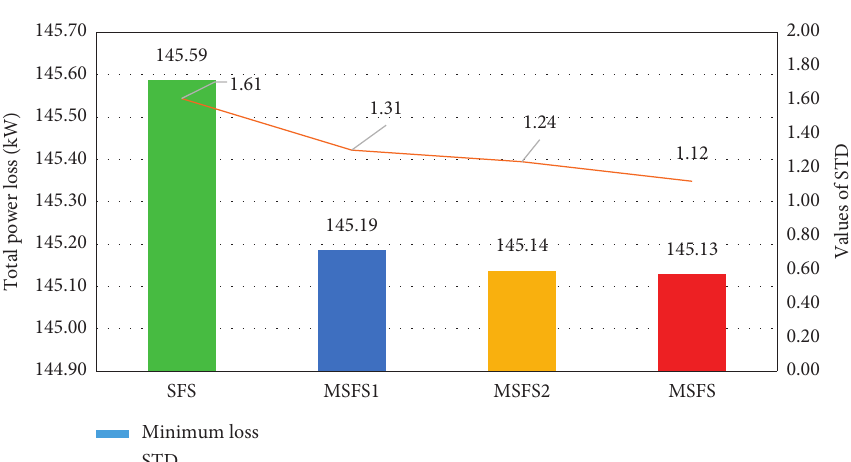
Figure 14: Minimum power loss and standard deviation of 50 trial runs obtained by SFS methods for case 2 of the 69-bus